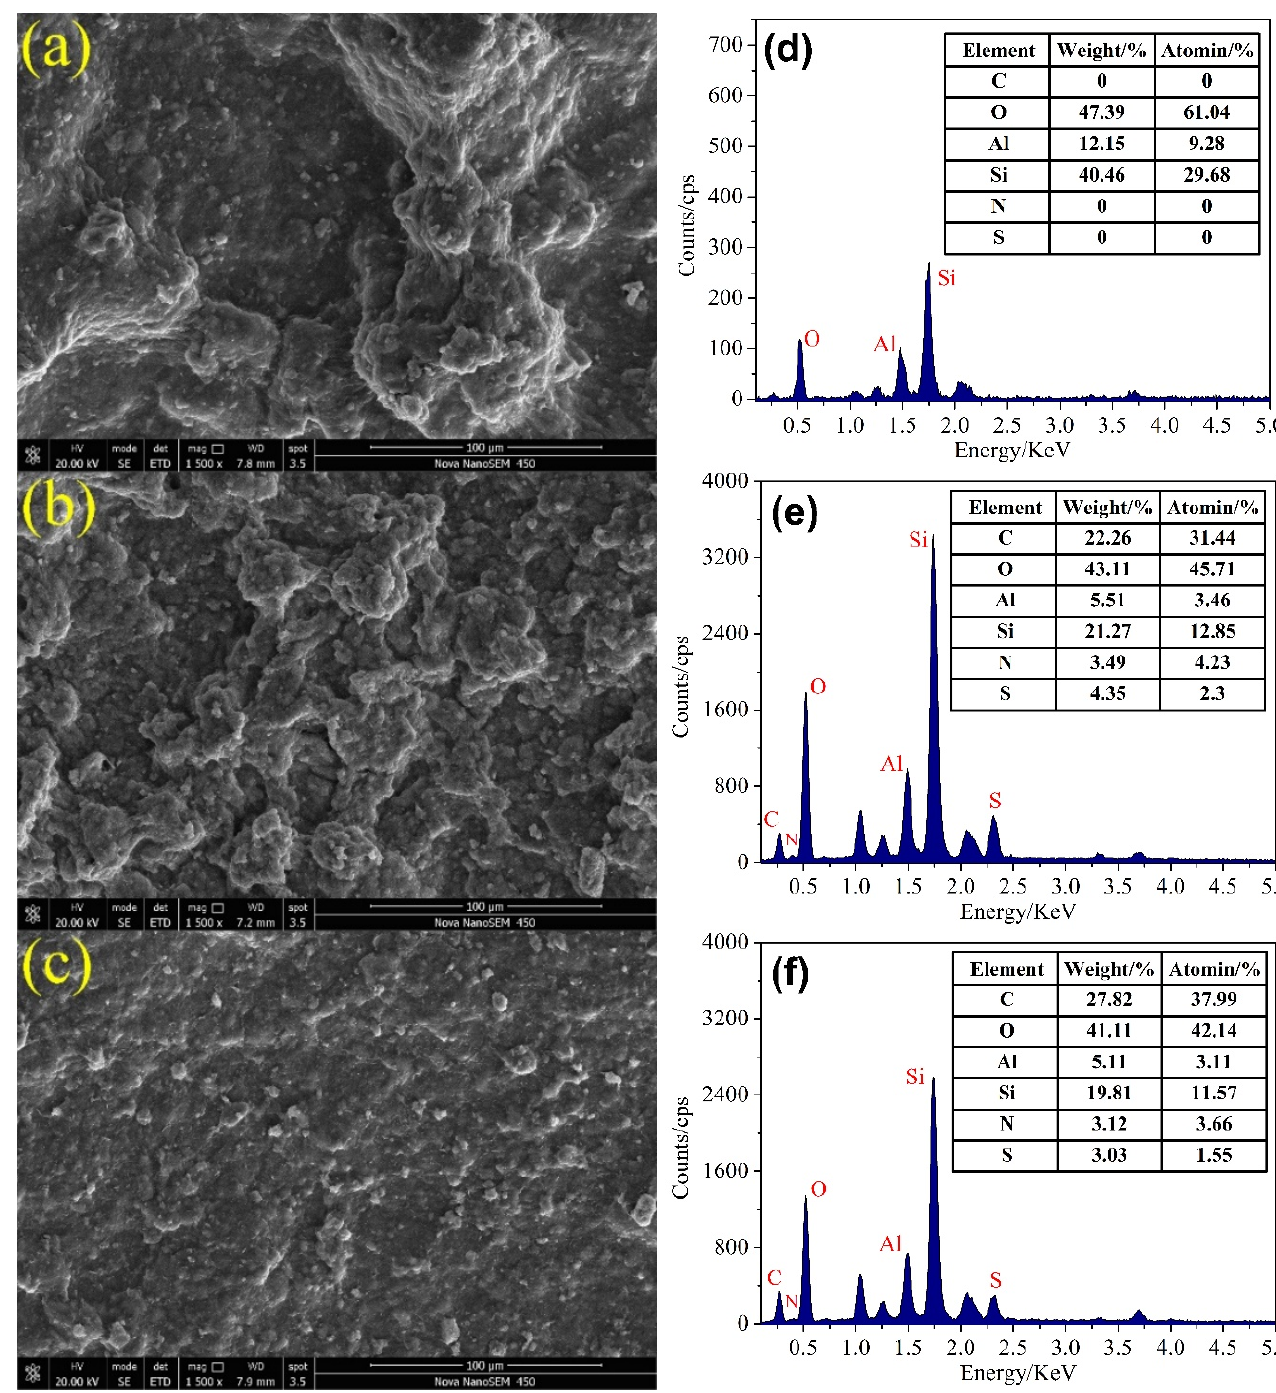
Figure 12. SEM images of the filter cake (1500×) and element content (( a ), ( d ), base fluid; ( b ), ( e ), base fluid with 2.0 wt% Driscal; ( c ), ( f ), base fluid with 2.0 wt% LDMS). fluid with 2.0 wt% Driscal; ( c , f ), base fluid with 2.0 wt%